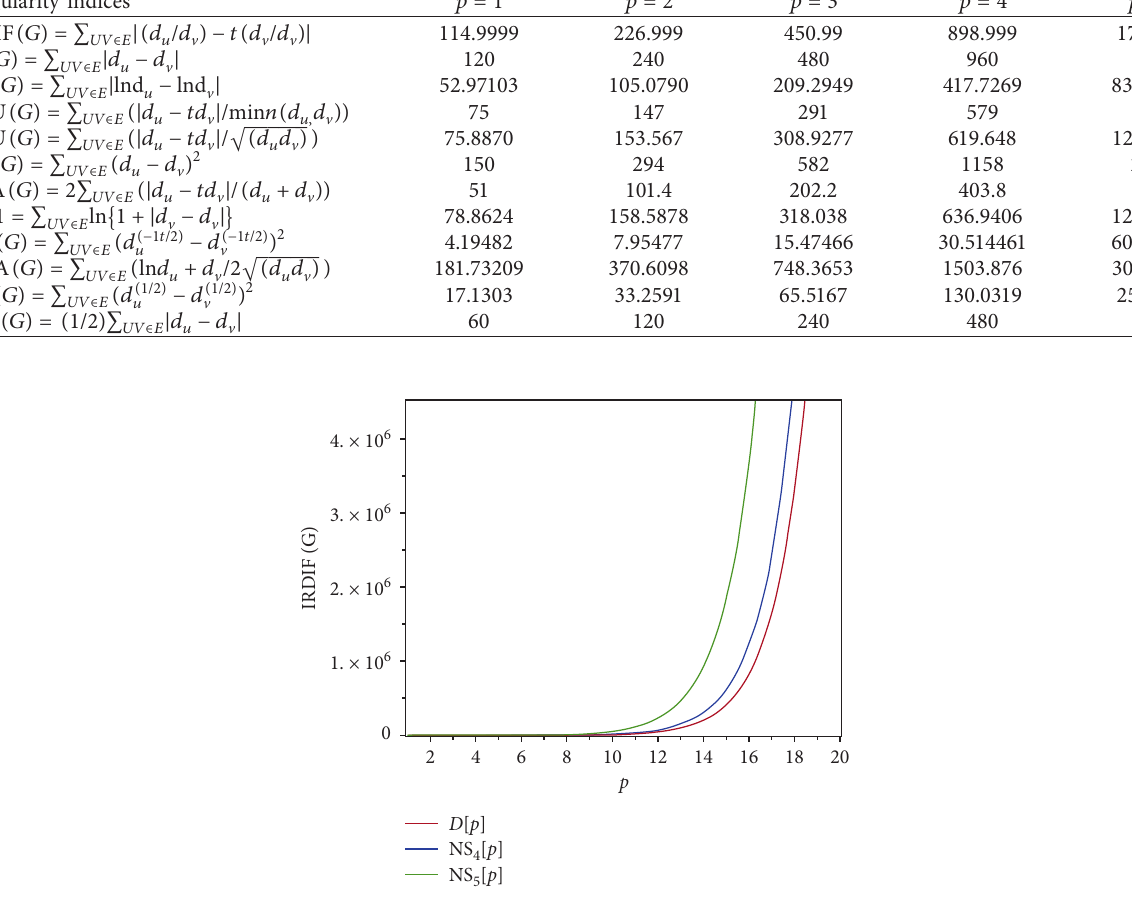
Figure 5: Graphs of irregularity index IRDIF.